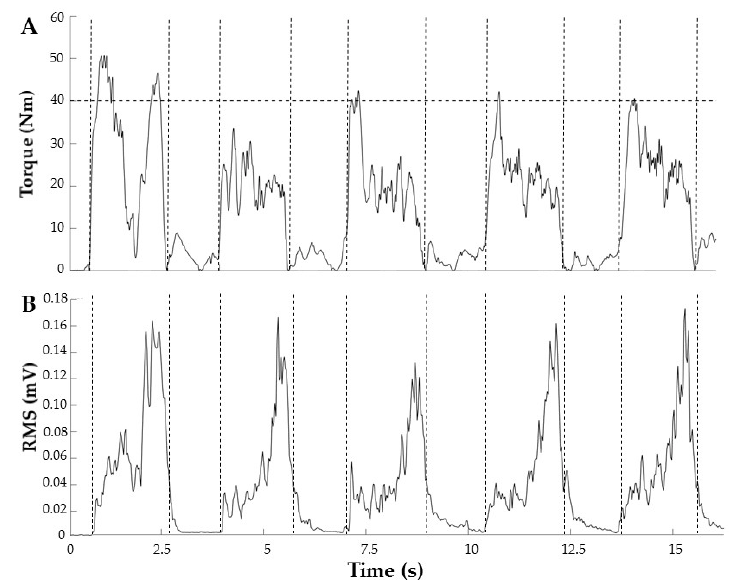
Figure 2. Torque ( A ) and electromyographic RMS ( B ) data from a representative participant during the concentric force control condition. The horizontal dashed line in panel A depicts the target torque and the vertical dashed lines indicate the time windows of subsequent trials. RMS: root mean square.